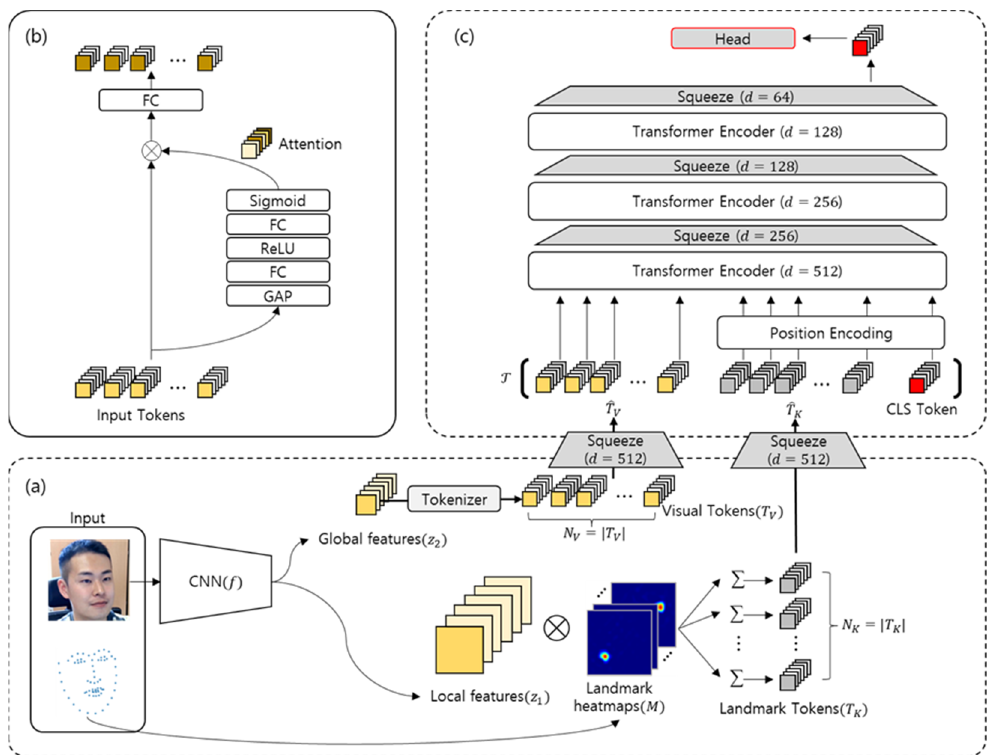
Figure 1. Illustration of the proposed Squeeze ViT. ( a ) An input image is fed to the CNN to yield the global and local features z 1 and z 2 . Each feature is transformed into visual tokens T V and landmark tokens T K , respectively. ( b ) The squeeze module adjusts the feature dimensions while maintaining robust discriminative elements. ( c ) Concatenated tokens T are fed to the Squeeze ViT having multiple stacks of encoders and squeeze modules to reduce the computational complexity.